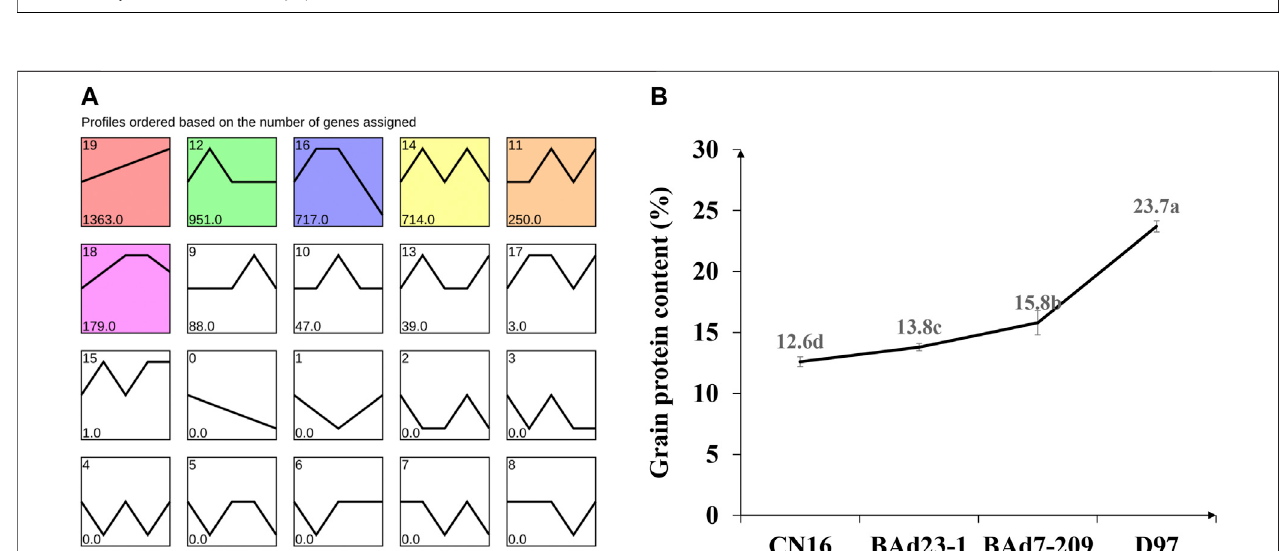
FIGURE 5 | Temporal expression patterns of DEGs (A) and grain protein content in CN16, BAd23-1, BAd7-209, and D97 (B) . Small letters a, b, c, and d indicate the signi fi cant difference at 0.05 level with Tukey ’ s two-way test.